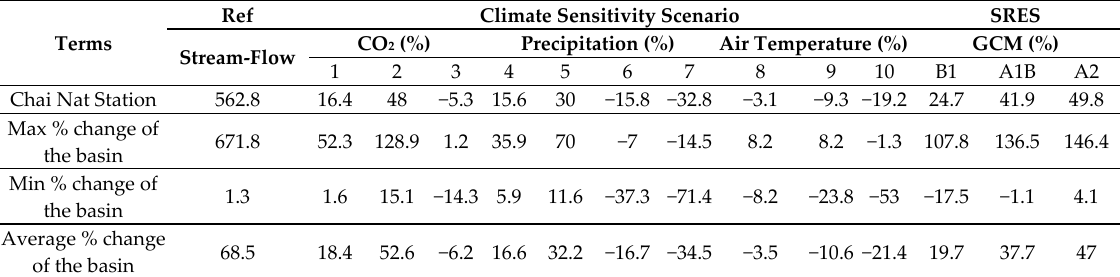
Table 7. Predicted relative percentage change of annual average streamflow from the baseline under different climate sensitivity scenarios and special report on emission scenario (SRES) (B1, A1B, and A2). It also includes the streamflow change at the Chai Nat